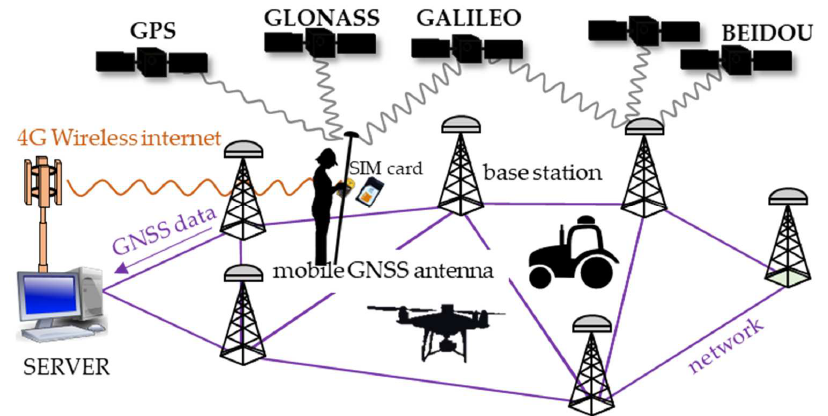
Figure 14. Operating principle of the French Teria NRTK system.